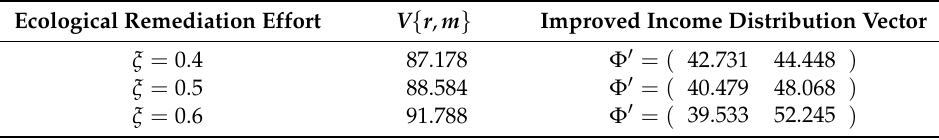
Table 7. Income distribution vector under different emission reduction efforts ξ